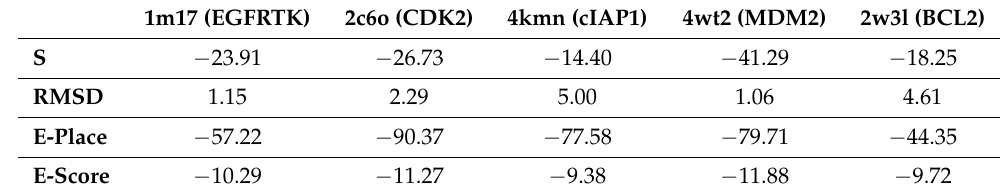
Table 2. Standard ligand energy readings against (1m17, 2c6o, 4kmn, 4wt2, and 2w31) domains.